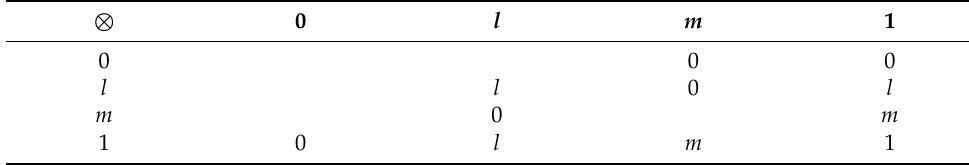
Table 21. The partial operation → . → 0 l m 1 0 1 1 1 l m 1 1 m l 1 0 m